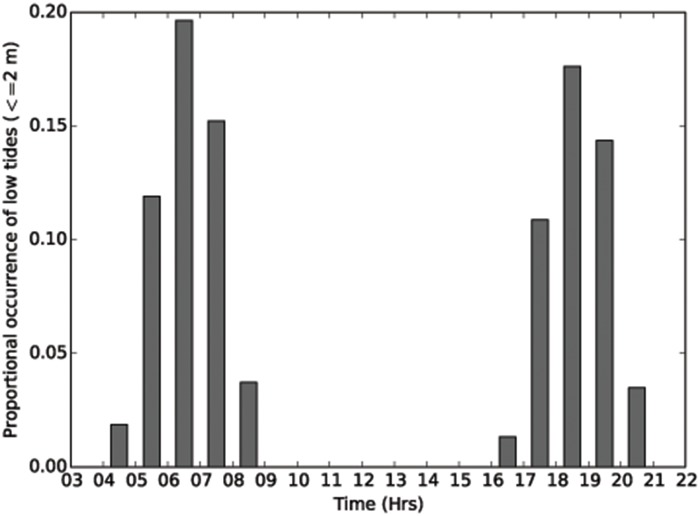
Hourly tide height data of spring low tides for North Maret I. from 2002–2014.The lengths of time corals are exposed for each day depends upon the lunar phase (see Figure D in S1 File) and maximum low tide exposure occurs in early morning and evening.